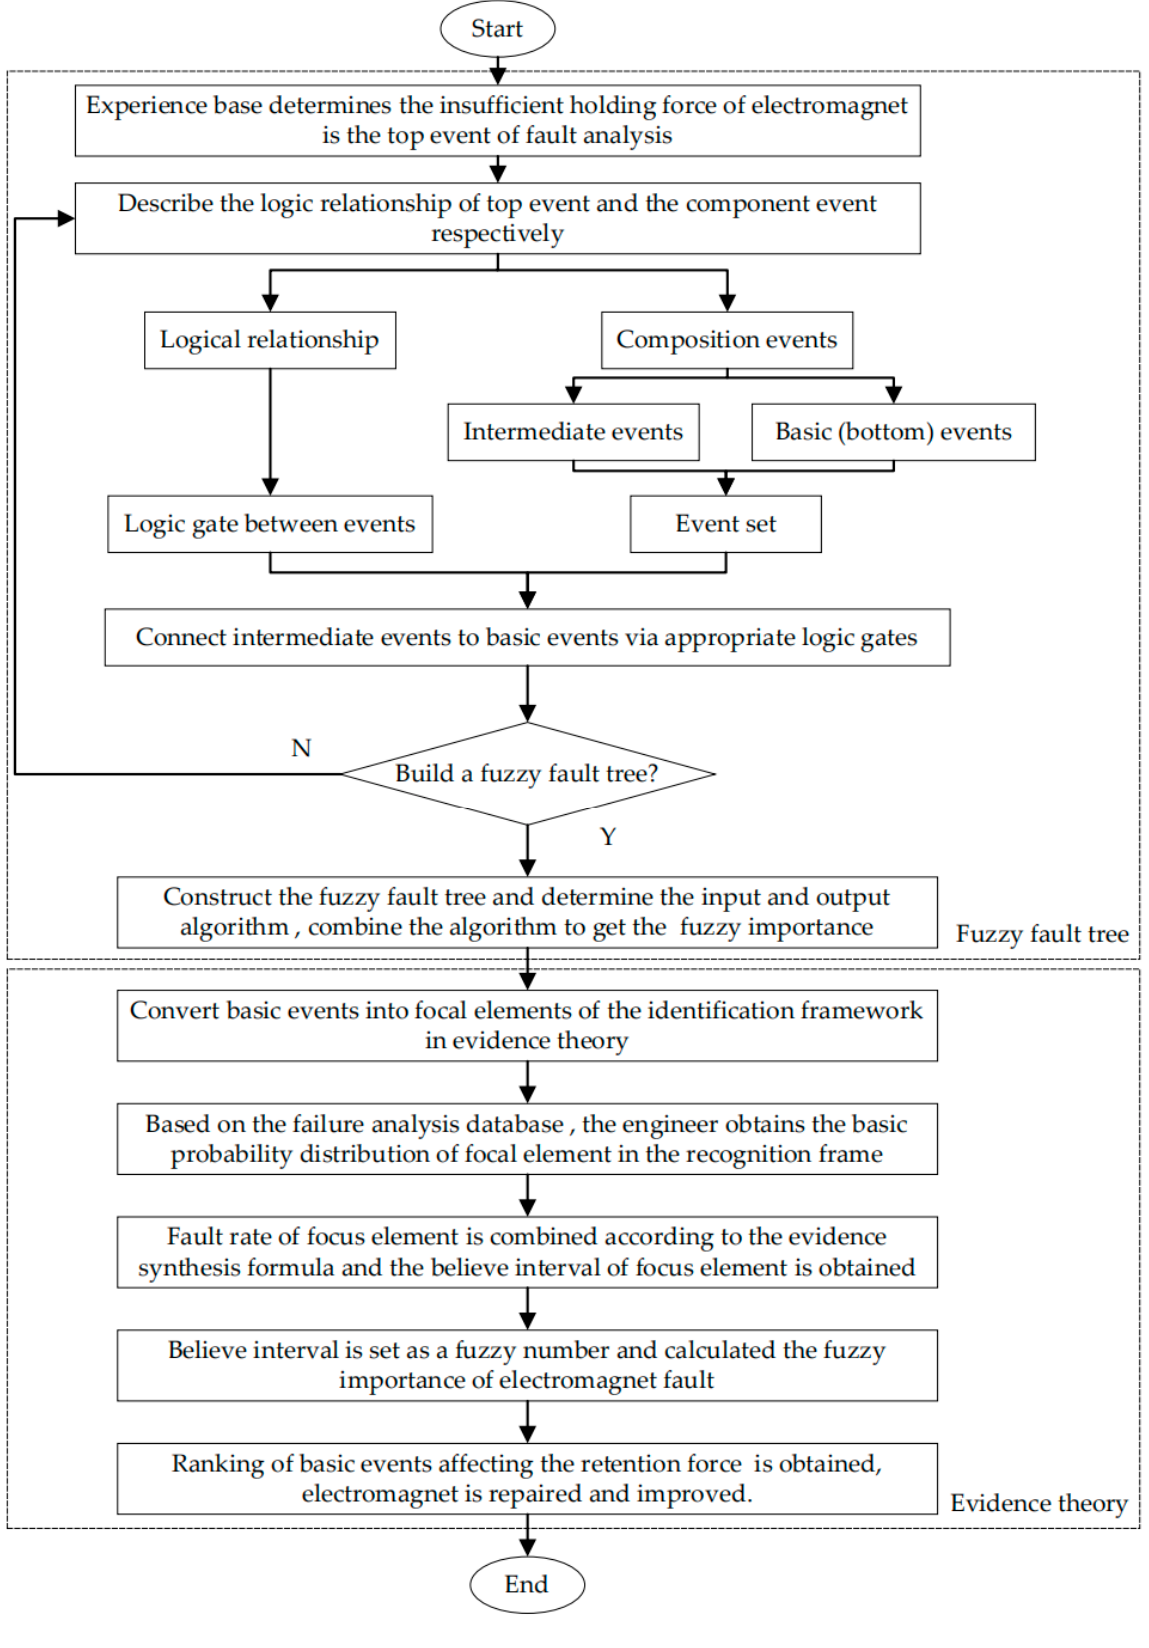
Figure 4. Flow chart of electromagnet manufacturing process fault analysis based on fuzzy fault tree and D–S evidence theory.